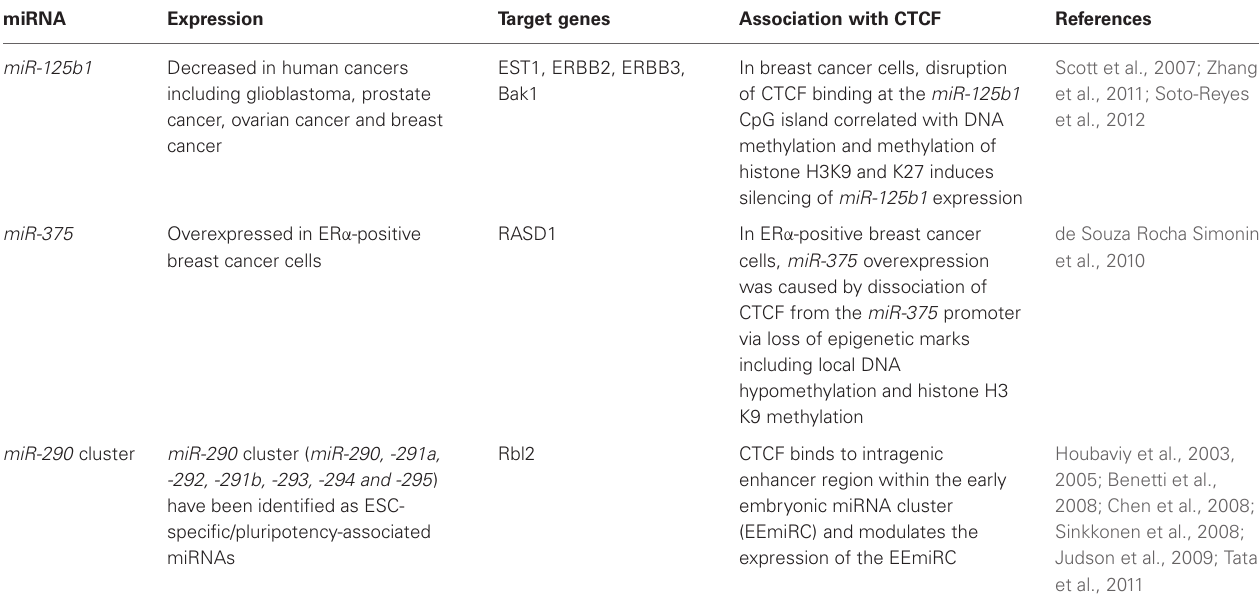
Table 1 | miRNAs associated with